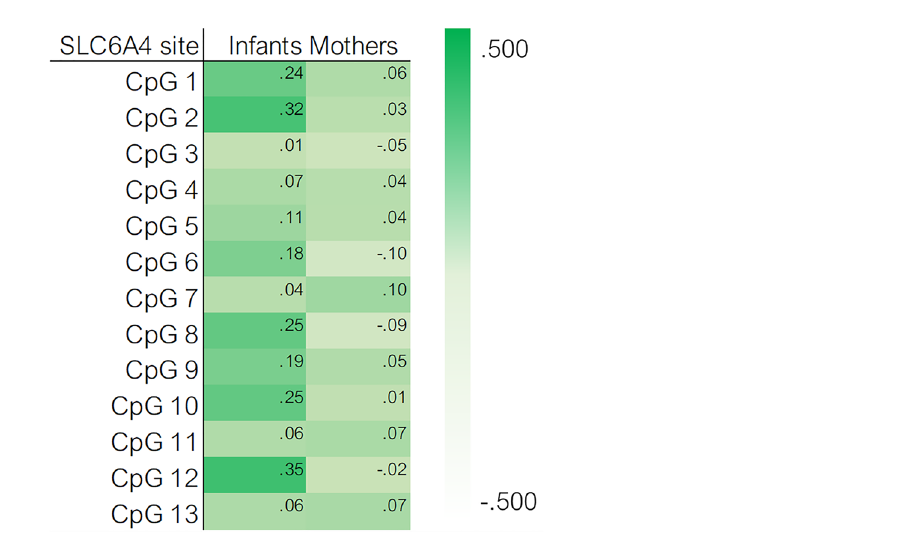
Figure 3. Heat map of the bivariate correlations between COVID-19-related prenatal stress and both infants and mothers’ SLC6A4 methylation.